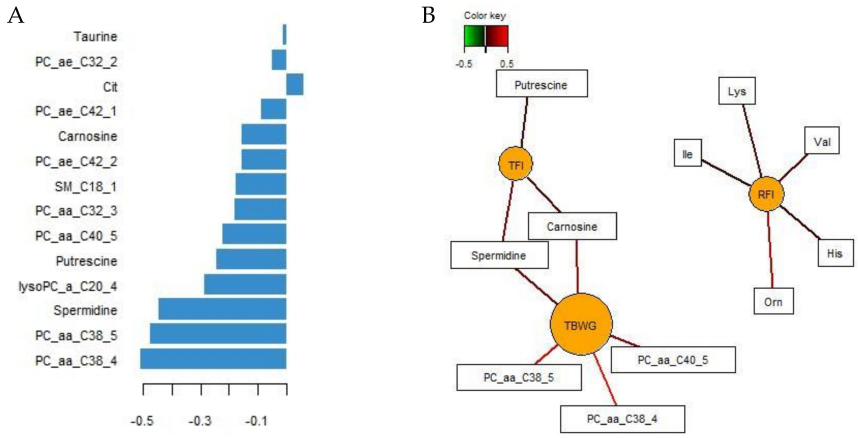
Figure 2. Determination of the most discriminant serum metabolites of low and high residual feed intake (RFI) broiler chickens fed either ad libitum or restrictively. ( A ) Loading plot of the most discriminant serum metabolites selected on the first component using sparse partial least-squares regression. ( B )